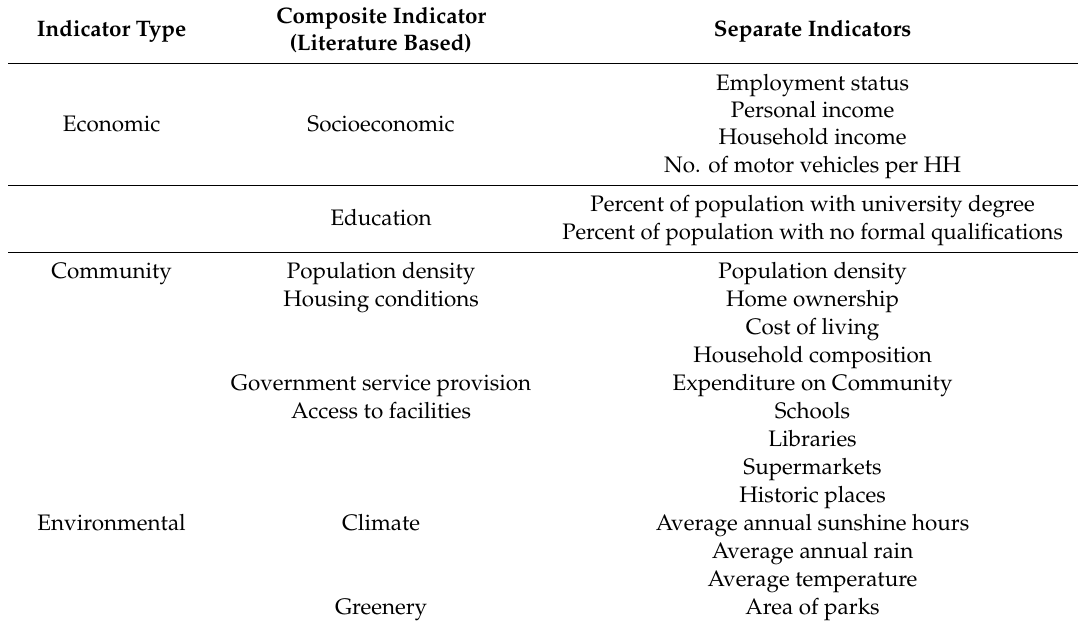
Table 2. QoUL indicators selected for the present study based on previous